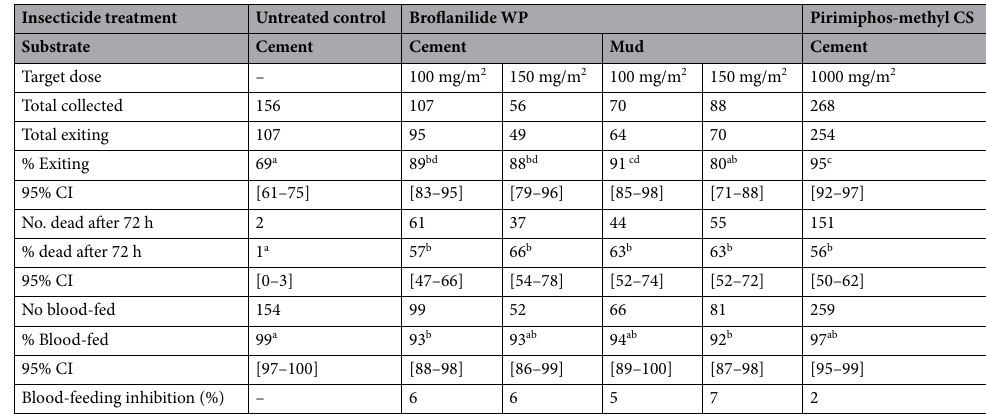
Table 2. Results with wild, free-flying pyrethroid-resistant An. gambiae sl entering experimental huts in Covè, Benin. Values bearing the same letter superscript along a row are not significantly different at the 5% level (P > 0.05, logistic regression).